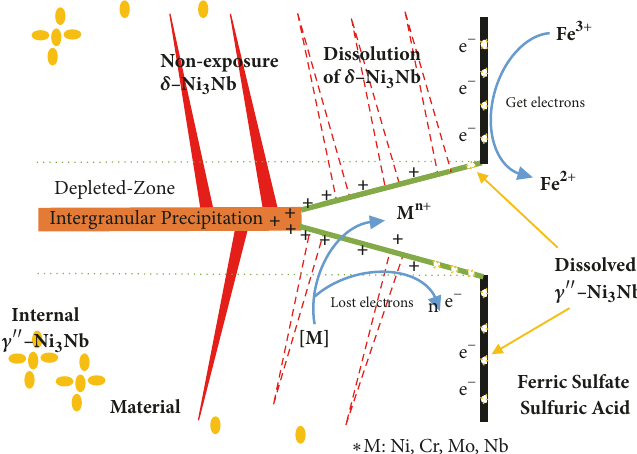
Figure 9: Intergranular corrosion mechanism of Inconel